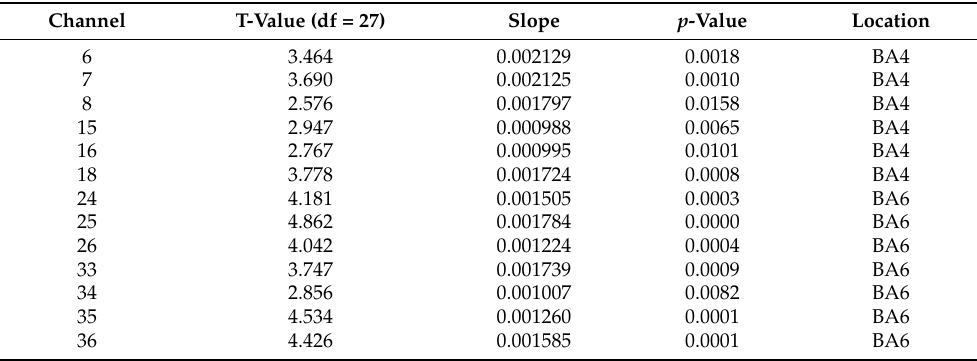
Table 2. Statistical details of channel-wise